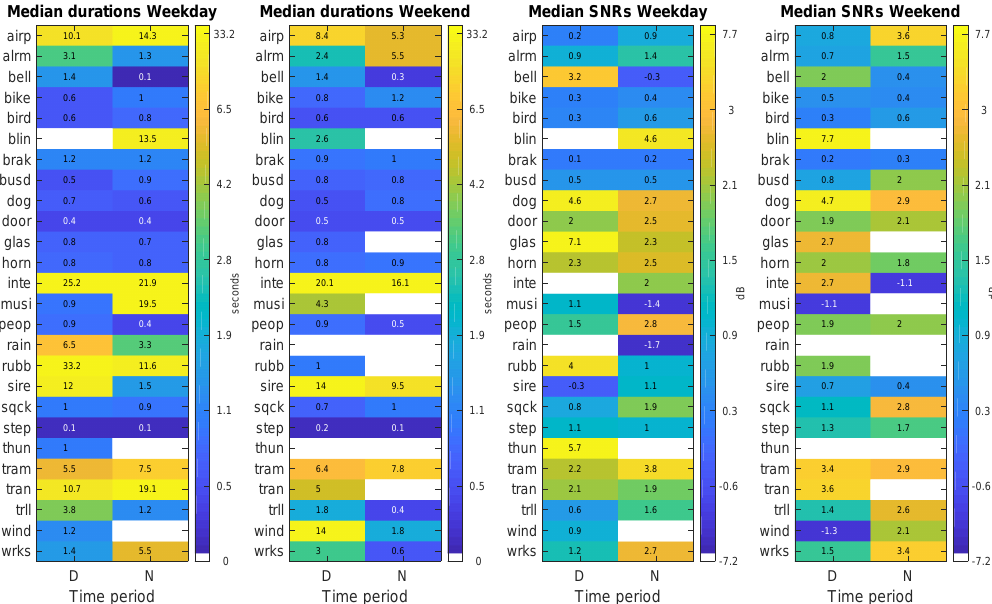
Figure 5. Results of the day–night analysis ( P DN matrices) differentiating weekday and weekend days for the following ANE features: median duration (two leftmost subfigures) and median SNR (two rightmost figures). Each subfigure shows the distribution of the corresponding ANE feature in terms of ANE subcategory and time